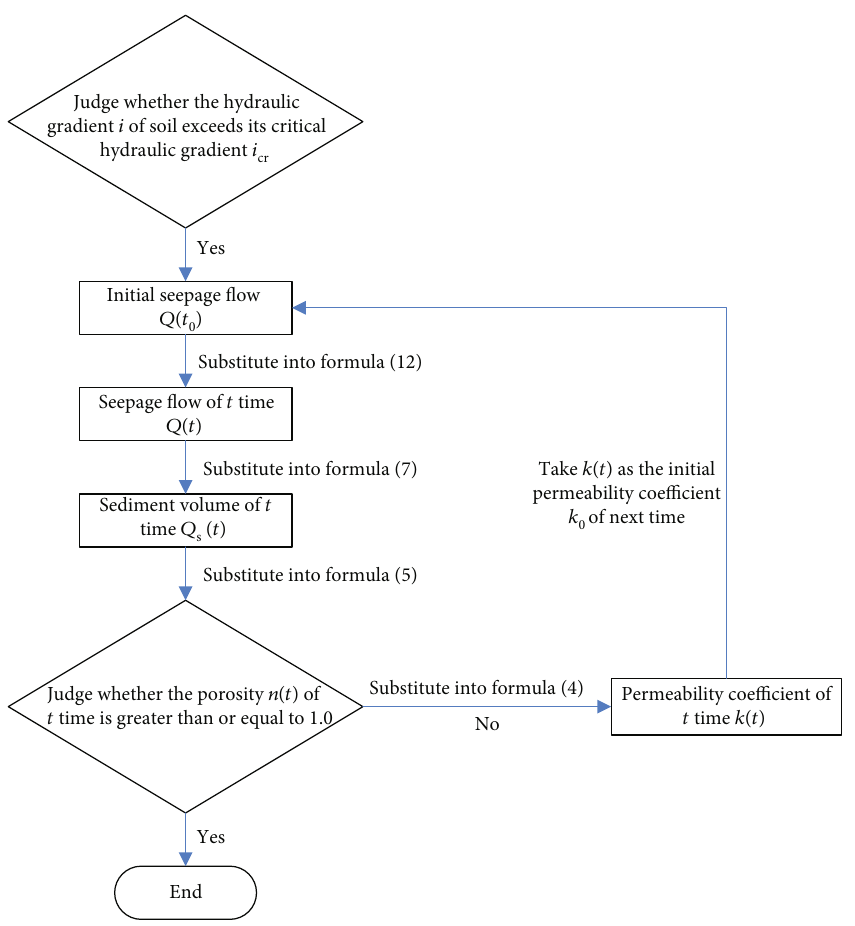
Figure 1: Flow chart for the governing equation of new piping model solving piping